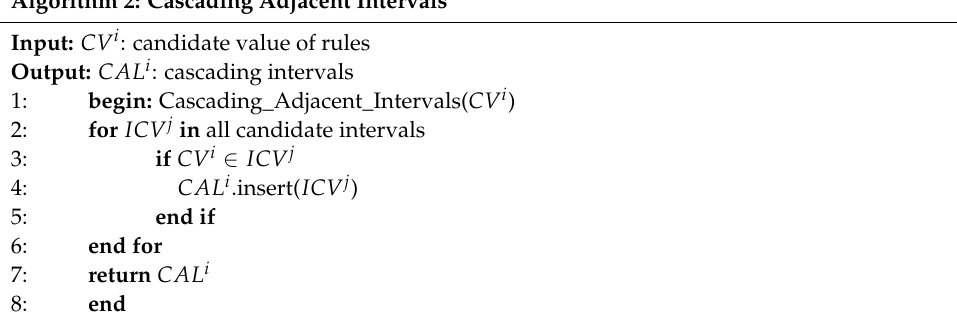
Algorithm 2 traverses each candidate interval and cascades the intervals that cover